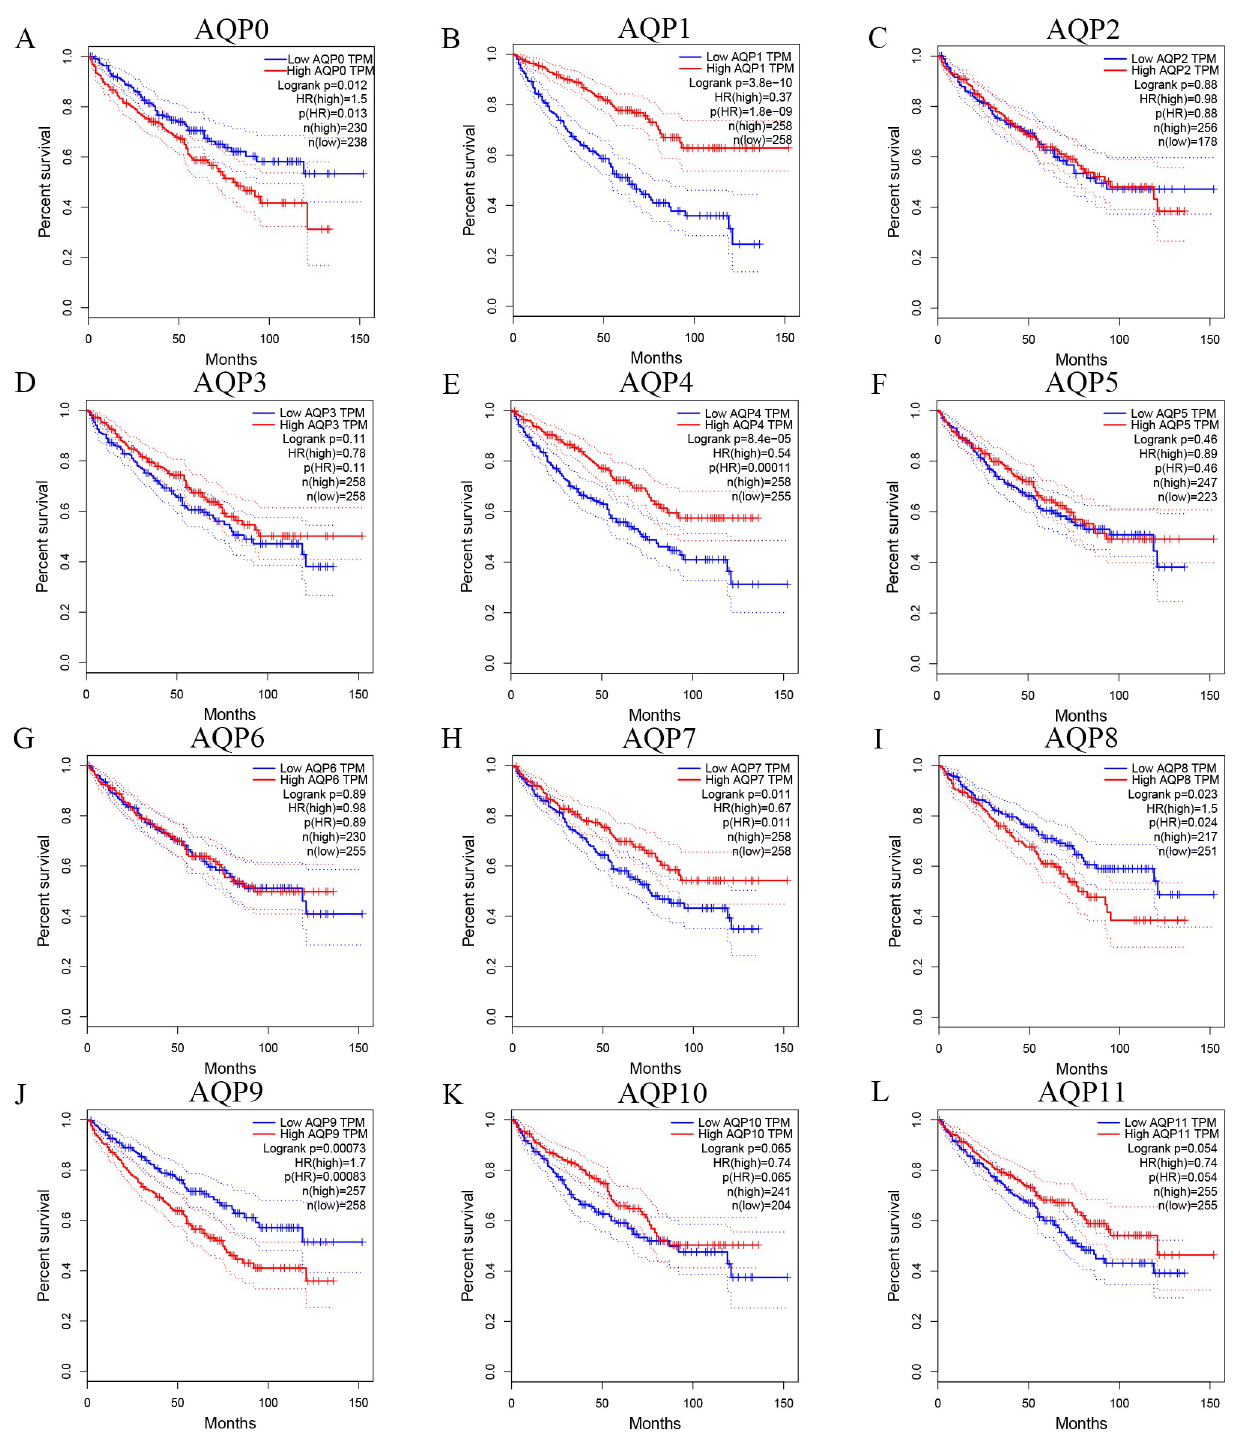
Fig 8. Prognostic significance of AQPs for the OS of ccRCC patients (GEPIA). High mRNA expression levels of AQP0/8/9 were significantly related to shorter OS of patients with ccRCC while high mRNA expression levels of AQP1/4/7 were obviously associated with longer OS time.